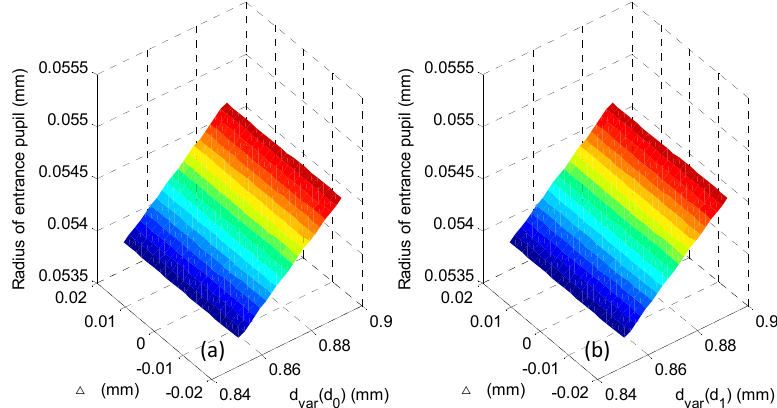
Figure 3. Radius of the entrance pupil determined using the four central rays for different d var and coplanar shift values ∆ of the point source: ( a ) variation of d var with d 0 , and ( b ) variation of d var with d 1 .